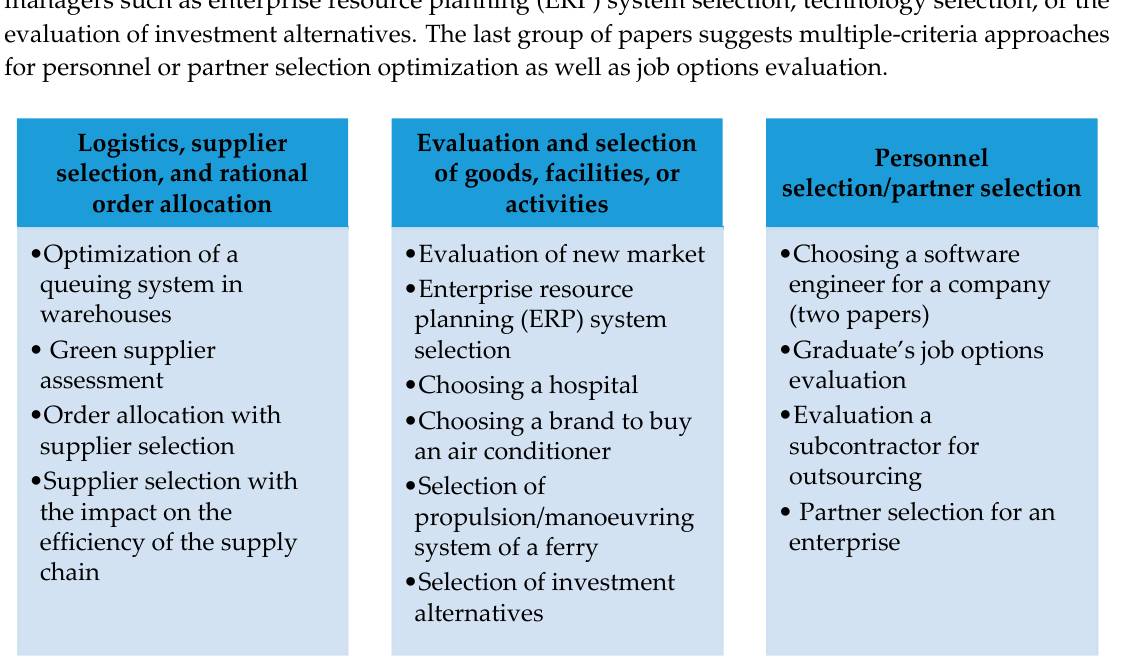
Figure 3. Research areas of case studies.